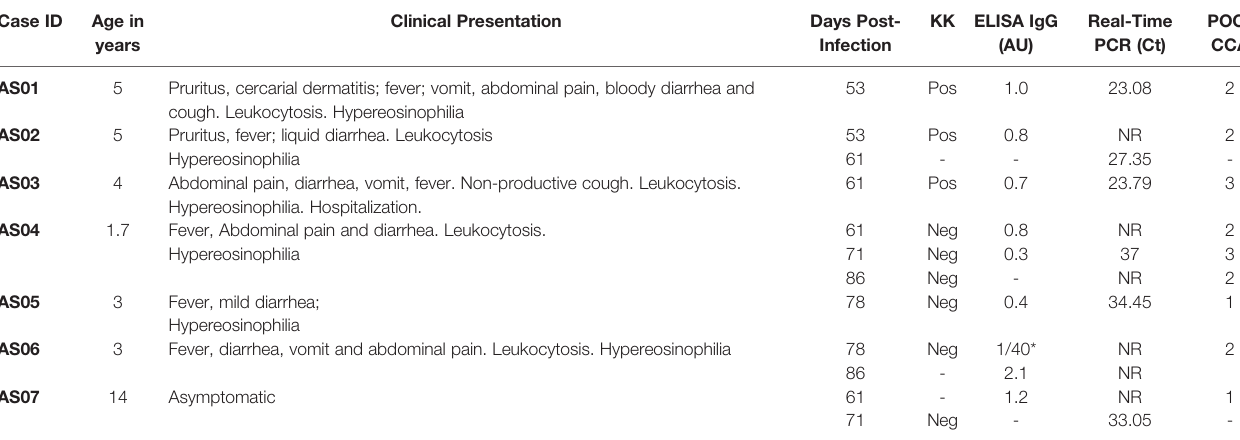
TABLE 1 | Baseline clinical characteristics of acute schistosomiasis cases in children, time of infection and results of laboratory testing. Case ID